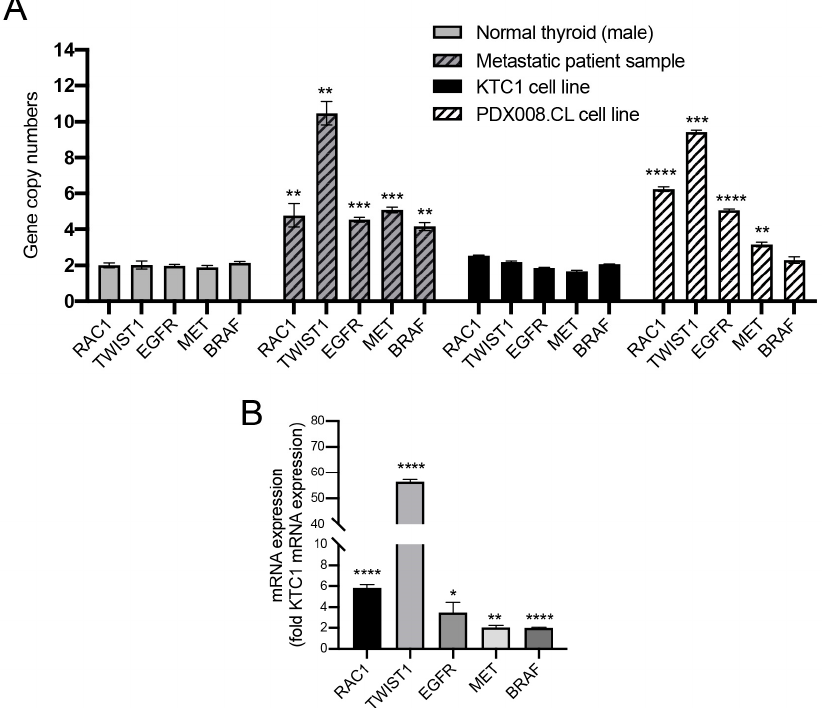
Figure 7. Copy numbers and expression of additional genes located on chromosome 7 in patient samples and PDX.008.CL cells. ( A ) There are additional copies of RAC1, TWIST1, EGFR1, MET and BRAF in comparison to normal thyroid, confirming aneuploidy of chromosome 7. High number of RAC1 and TWIST1 gene copies might indicate duplications/amplifications by chromothripsis at the tip of 7p. ( B ) High expression of genes located on chromosome 7 such as RAC1, TWIST1 and EGFR1 indicate a possible correlation between gene copy number and mRNA expression. n = 3–6, * = p < 0.05, ** = p < 0.005, *** = p < 0.0005, **** = p < 0.0001